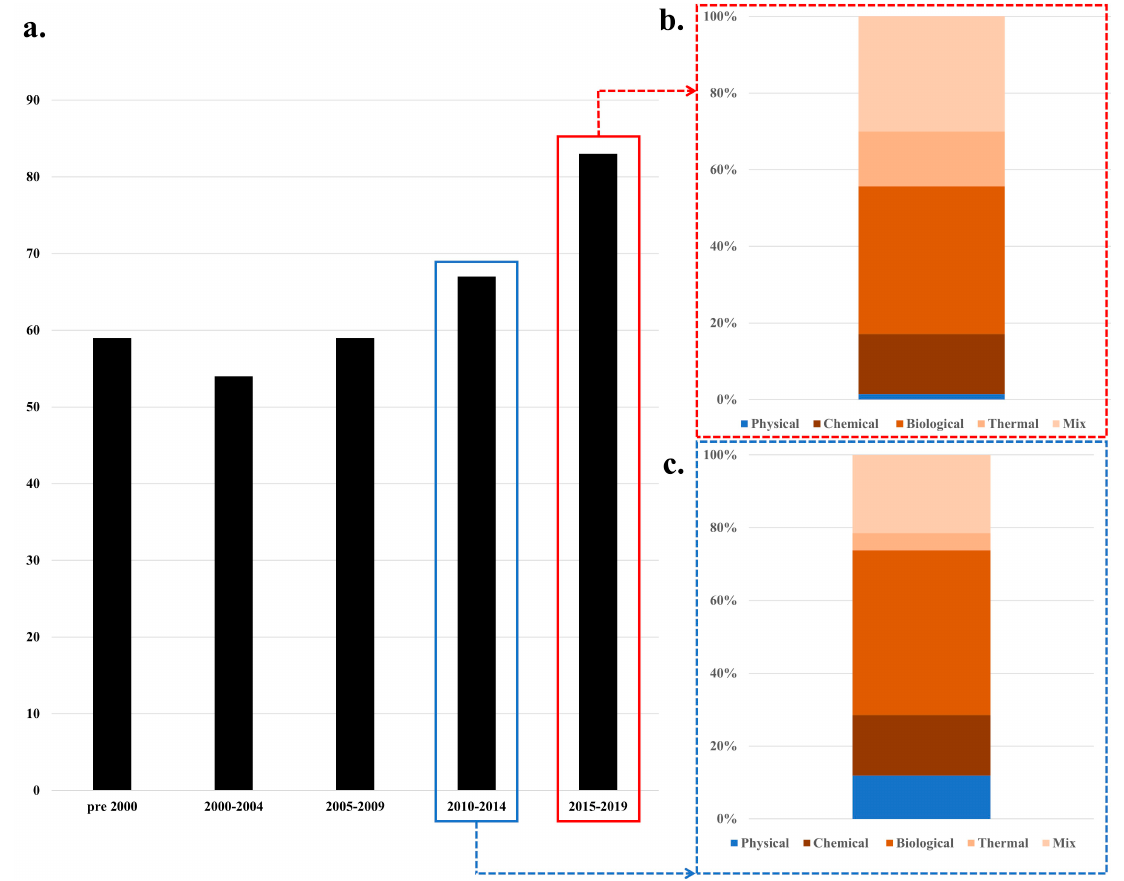
Figure 2. ( a ) Comparison of the number of research papers, reviews, books and conference proceedings published in the last 20 years and before 2000; ( b ) Classification of the different types of treatments studied from 2015 to 2019; ( c ) Classification of the different types of treatments studied from 2010 to 2014. (All data were obtained using the keywords “Minimization sewage sludge” in SCOPUS).